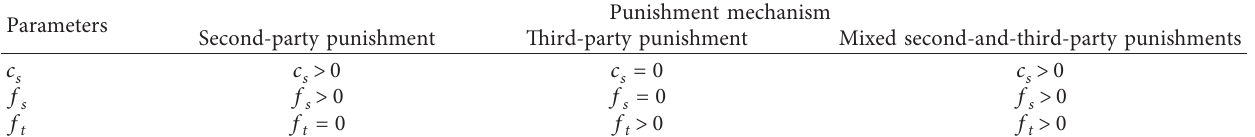
Table 1: Relevant parameters under different punishment